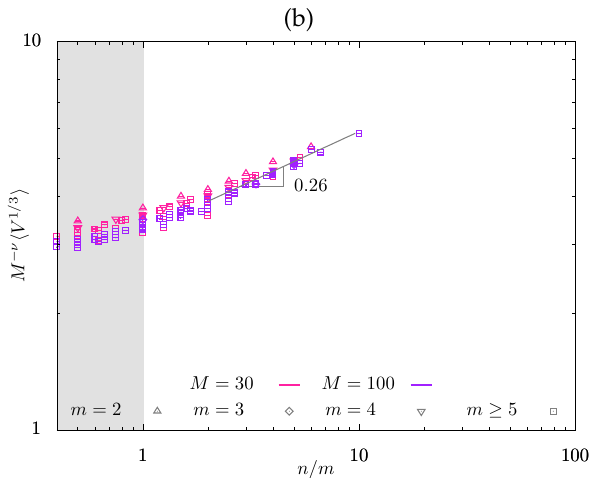
V 1/3 , as a function of n for a ∼